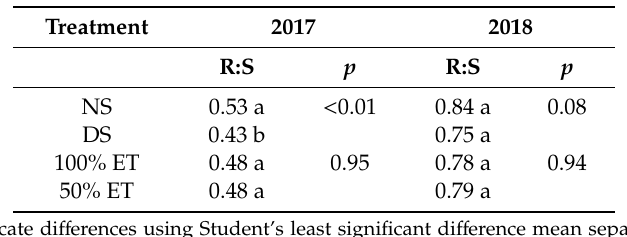
Table 1. Mean root to shoot (R:S) ratios of peach trees harvested during the winter of 2017 ( n = 16) and 2018 ( n = 8) after the treatments: (1) Delay of senescence (DS) or normal senescence (NS) and (2)